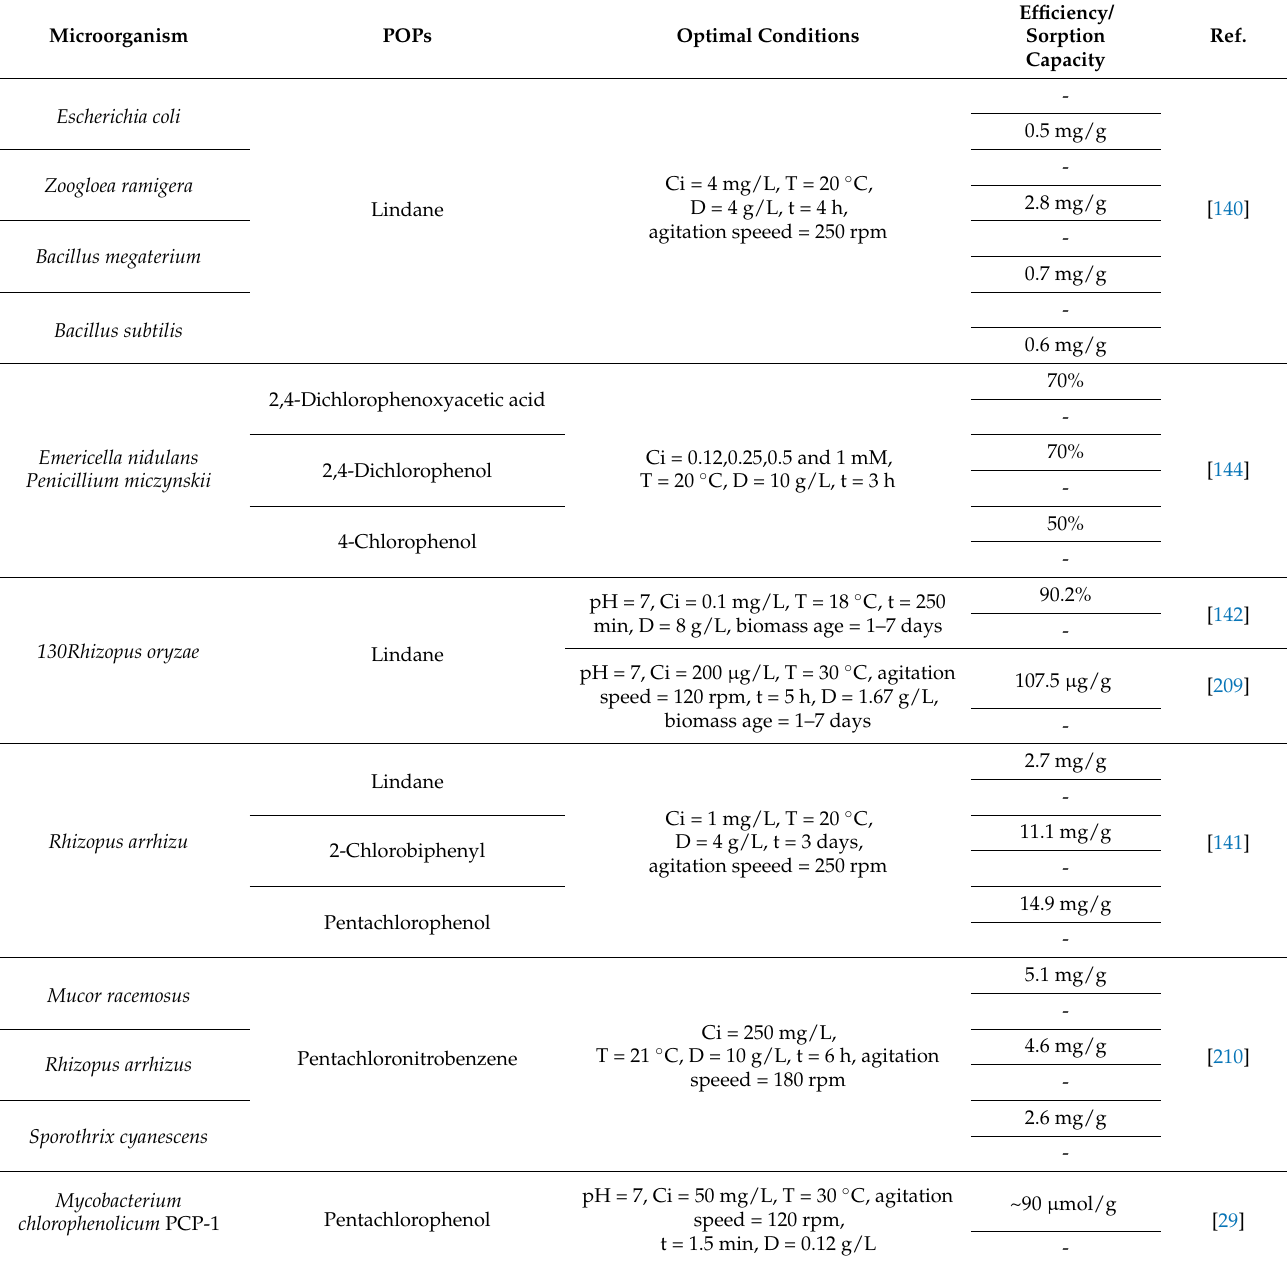
Table 5. Persistent organic pollutant removal by inactive microbial